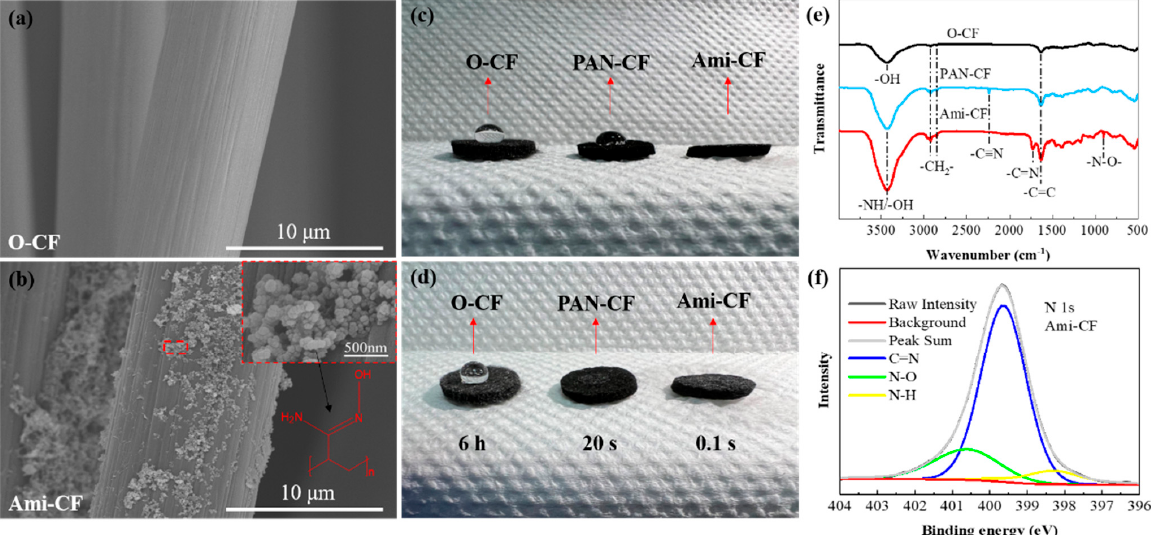
Figure 2. SEM images of ( a ) O ‐ CF and ( b ) Ami ‐ CF, ( c , d ) Comparison of hydrophilicity of O ‐ CF, PAN ‐ CF and Ami ‐ CF, ( e ) FTIR images of O ‐ CF, PAN ‐ CF and Ami ‐ CF, ( f ) XPS image of Ami ‐ CF.